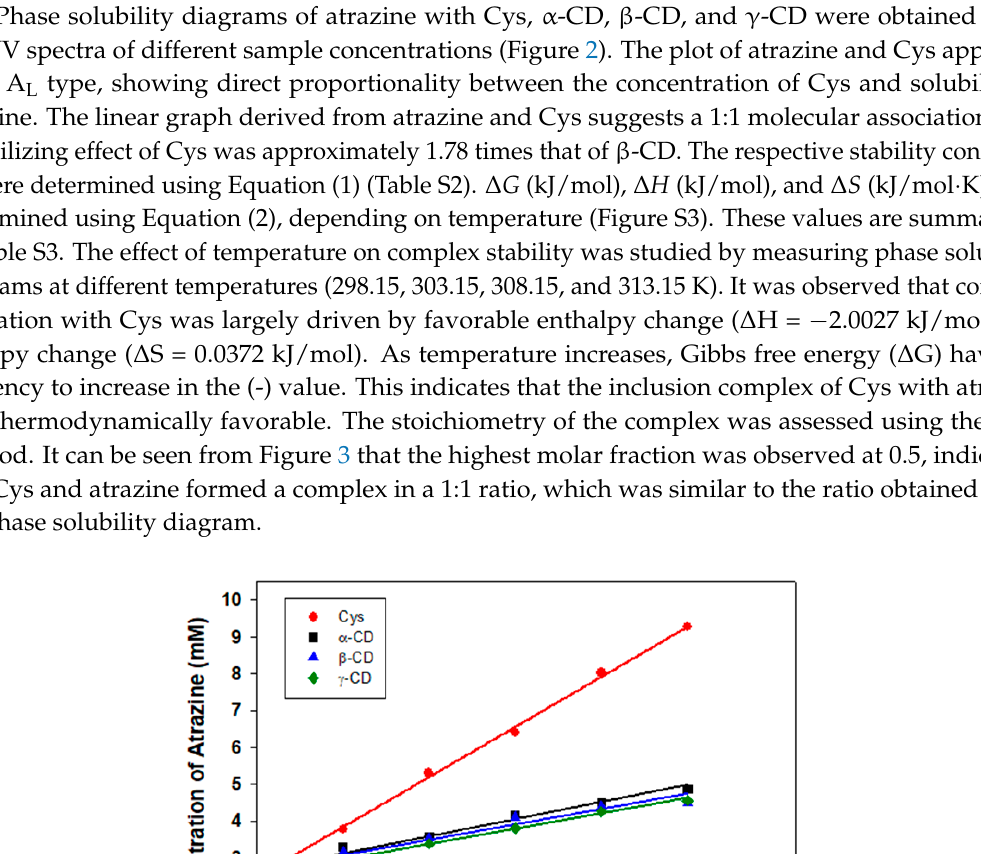
Figure 1. 1 H NMR spectra of ( a ) atrazine; ( b ) cyclosophoraoses (Cys); and ( c ) atrazine/Cys inclusion complex.